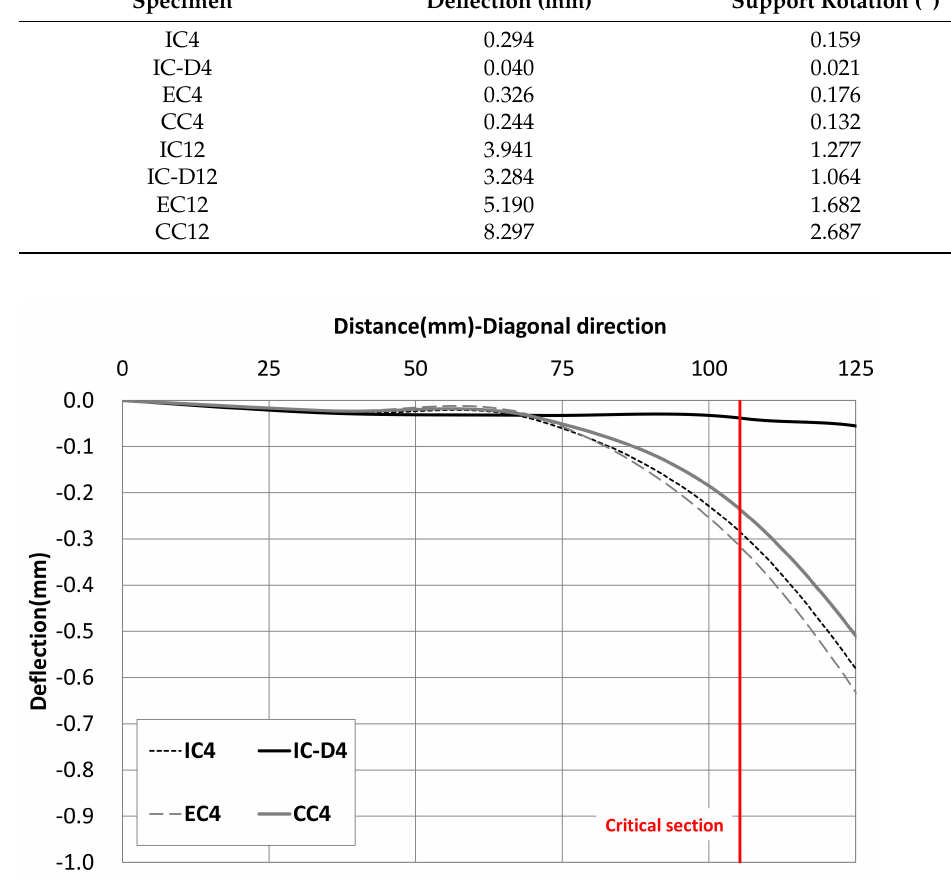
Figure 9. Slab deflection at the critical section with TNT 4